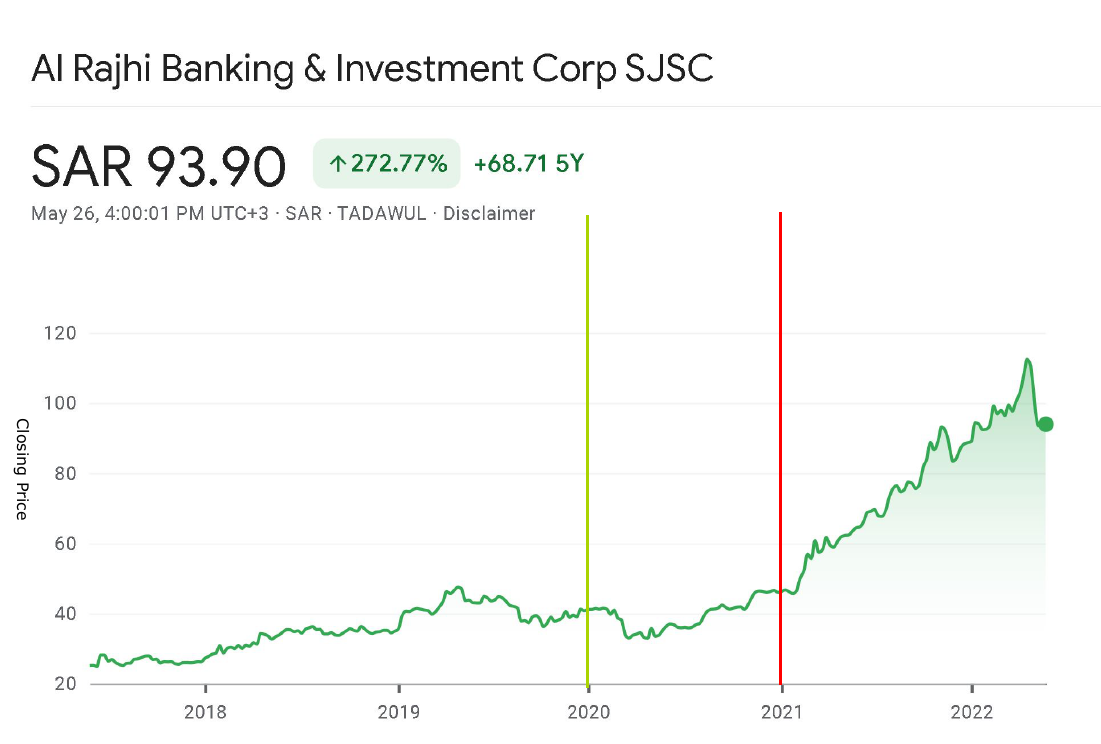
Figure 7. Behaviour of Al-Rajhi Banking and Investment (1120) during the training and testing